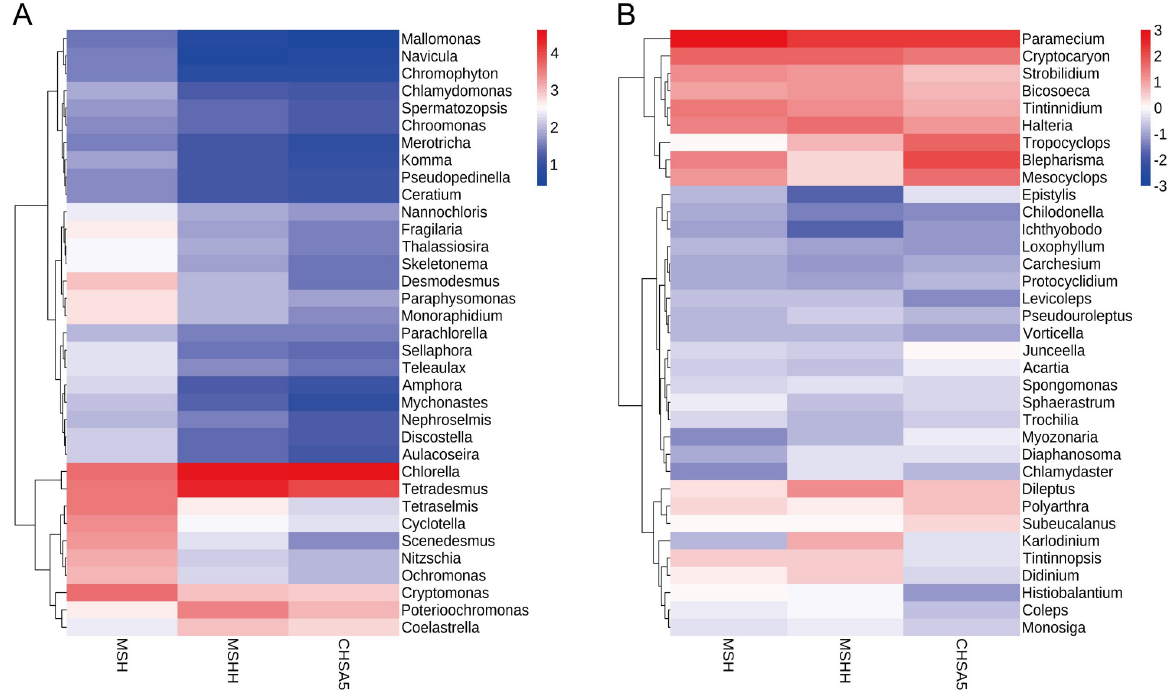
Fig 8. Heat maps showing the phytoplankton (A) and zooplankton (B) in the MSH, MSHH, and CHSA5 test waters. The horizontal coordinate and the right and left sides indicate the sample names and classes of phytoplankton or zooplankton, respectively. The color of the heat map is negative when the values are below the mean and positive when above. Values of the heat maps, as indicated by the color scale at the top right corner, are calculated as the standard score (Z-values) z = (x- μ )/ σ , where: x is the relative abundance of a specific group of phytoplankton. μ is the mean of the relative abundance of all different groups of phytoplankton. σ is the standard deviation of the relative abundance of all different groups of phytoplankton. The similarity metric was calculated by Bray–Curtis distance for hierarchical clustering using R software. MSH: the mosquito was living in water from the Meishe river only. MSHH: the mosquito was living with water from the Meishe river supplemented with wild Chlorella HOC5. CHSA5: the mosquito was living in waters from the Meishe river supplemented with recombinant Chlorella CHSA5.